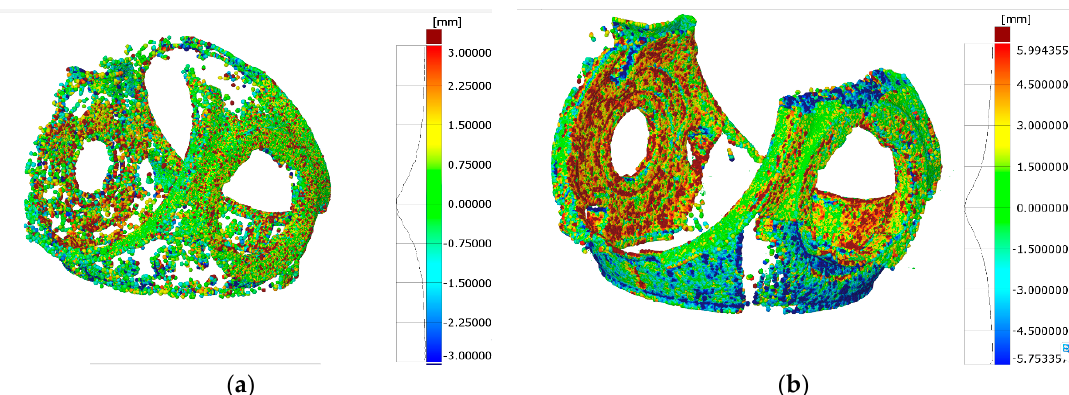
Figure 15. 3D representation of measured part in shop-floor environment with targetless orientation approach: ( a ) surface point comparison against reference mesh with sparse point cloud; and ( b ) surface point comparison against reference mesh with dense point cloud (quarter resolution).